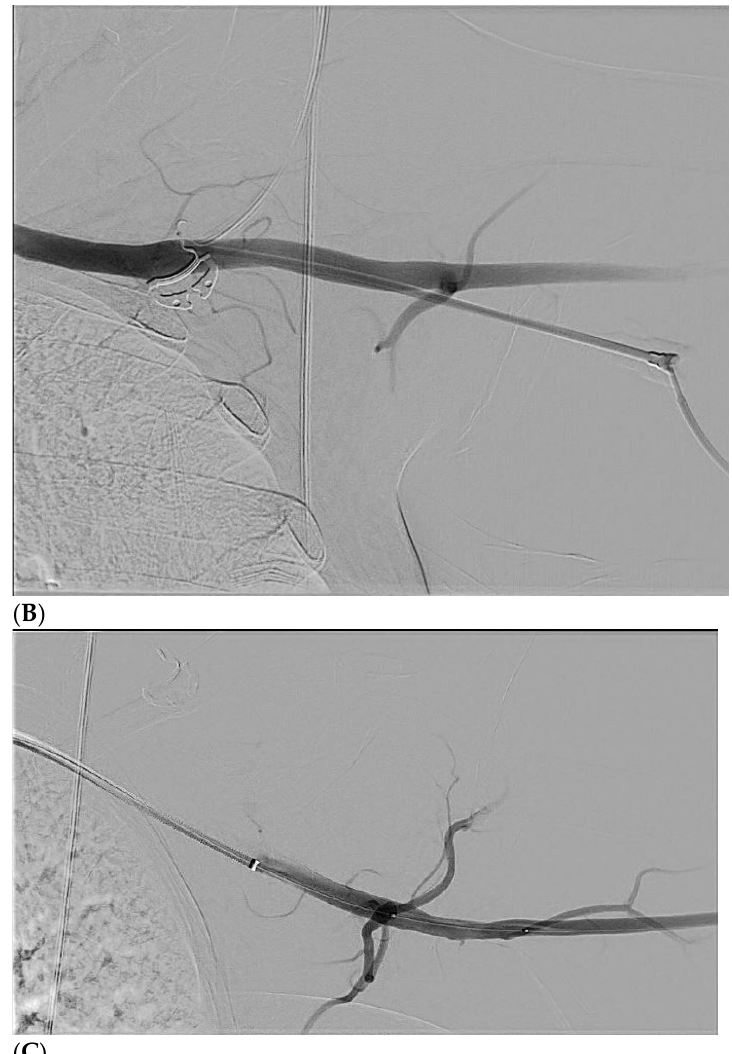
Figure 1. ( A ): Left axillary region. Puncture was made in the third segment of the AxA. The picture shows a 12F sheath (yellow star), which was introduced into the AxA. In addition, the two preloaded Perclose ProGlide PVCDs (Abbott Vascular, Santa Clara, CA, USA) (yellow arrows) can be seen. ( B ): Baseline angiography of the axillary artery (AxA) after ultrasound guided puncture in the third segment of the vessel. Consistent with the results of a previous CT scan, no relevant atherosclerotic changes were detected in this vessel segment, and the vessel diameter was >5 mm. The patient required pre-planned treatment for chronic thoraco-abdominal aortic aneurysm. ( C ): After successful fenestrated endovascular aortic repair (FEVAR) with fenestrations for the left and right renal artery, coeliac trunc, and superior mesenteric artery, closure of the axillary puncture site was performed using two Perclose ProGlide PVCDs (Abbott Vascular, Santa Clara, CA, USA). The control angiogram via the left femoral access showed no complications at the AxA puncture site.